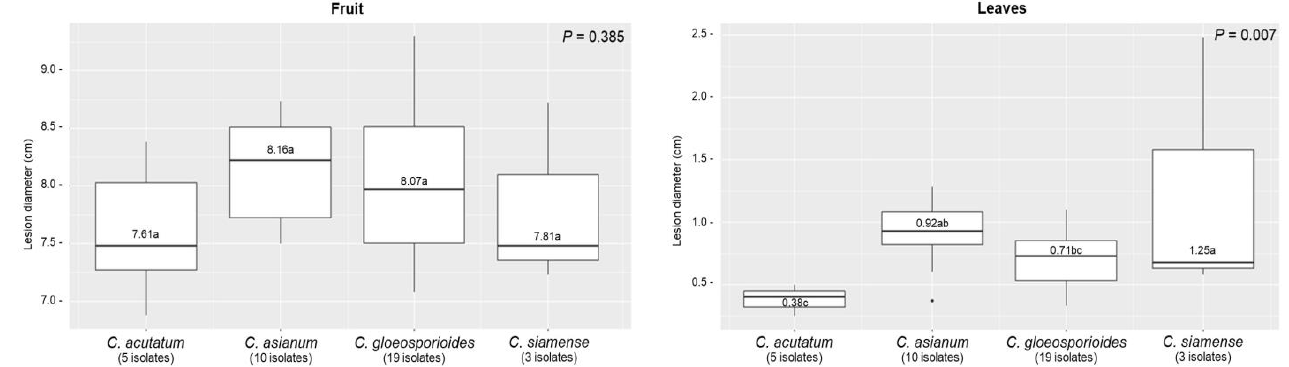
Figure 6. Box plots showing the variation of disease lesion diameter amongst four Colletotrichum species associated with mango anthracnose at 5 days after inoculation with a mycelial plug on unwounded NDMST mango fruit and leaves. Vertical lines are median. Means followed by the different common letter are significantly different according to the Tukey-test.